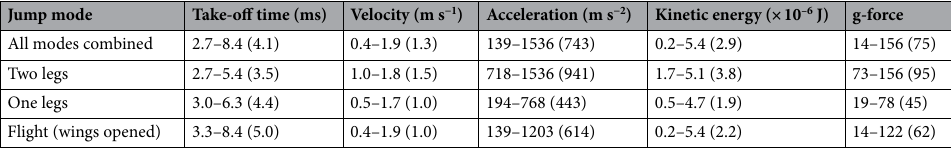
Table 2. Kinematic parameters of jumping conditions in the marsh beetle Scirtes hemisphaericus (Coleoptera: Scirtidae), average values in brackets.